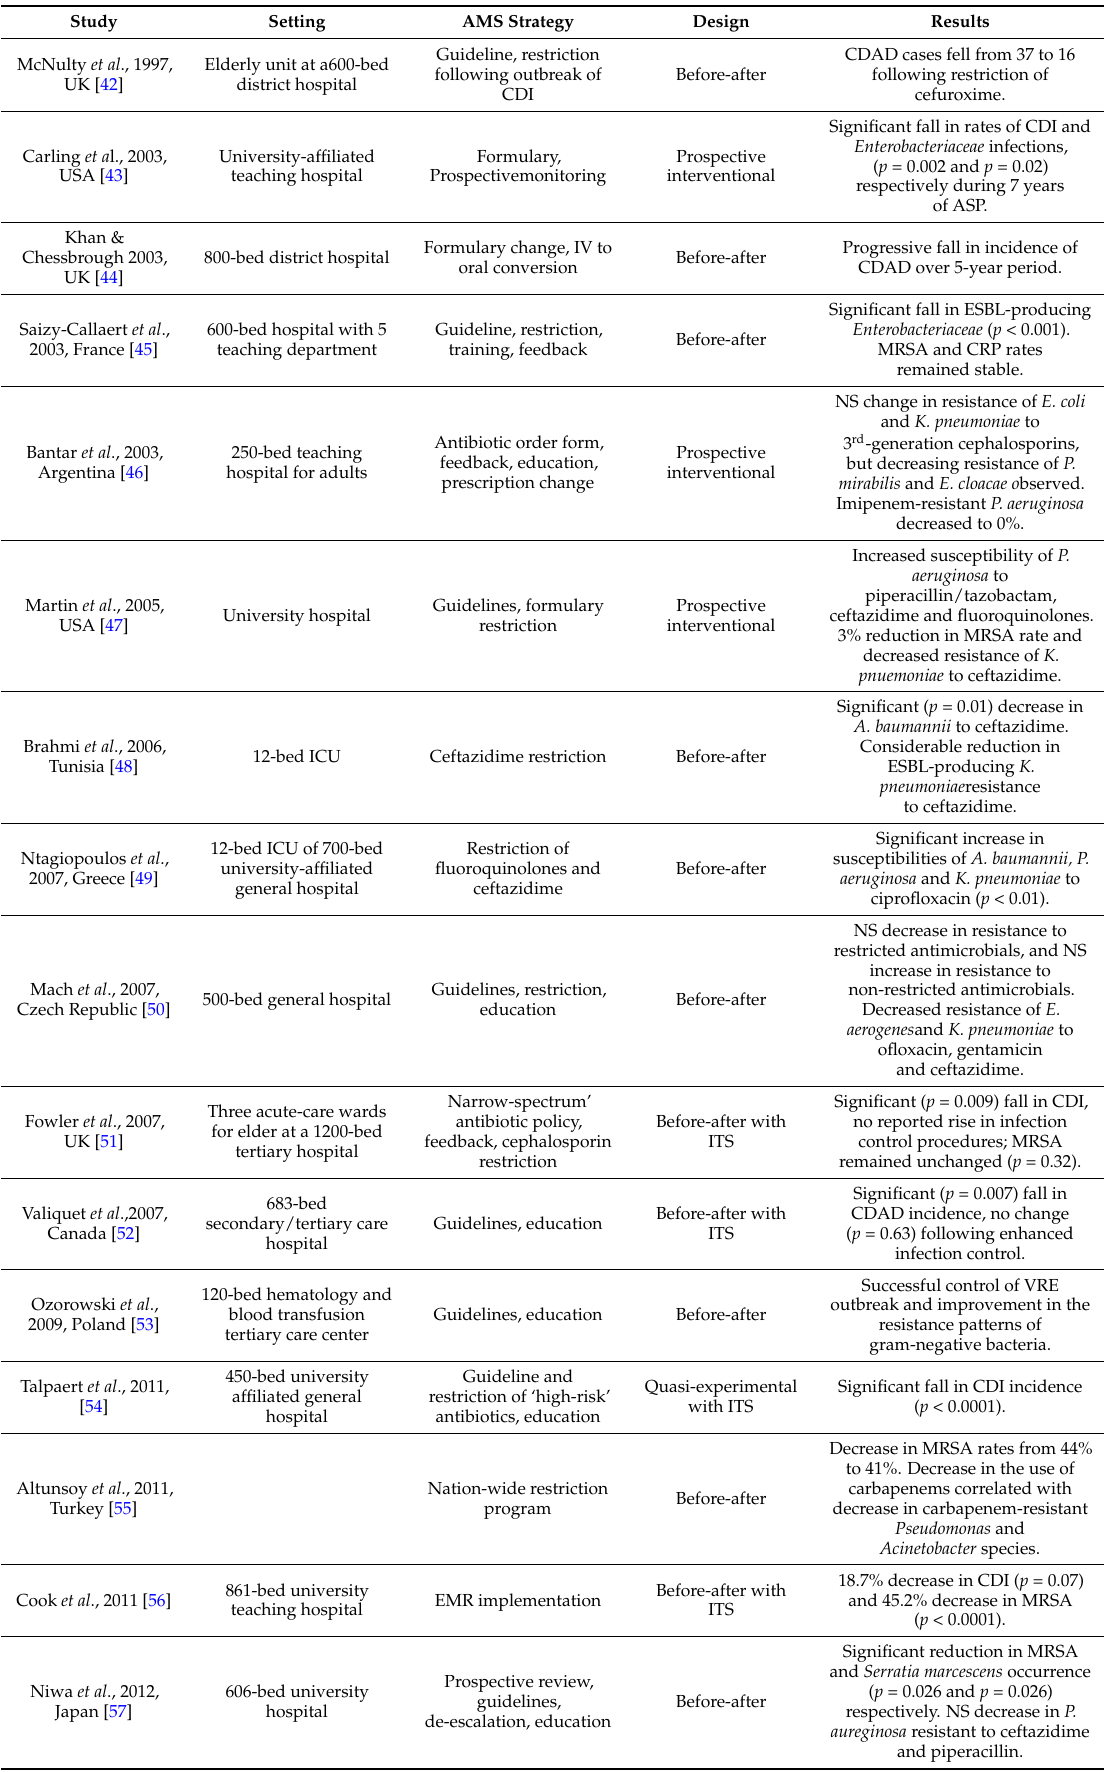
Table 3. Impact of ASP on resistance patterns and C. difficile